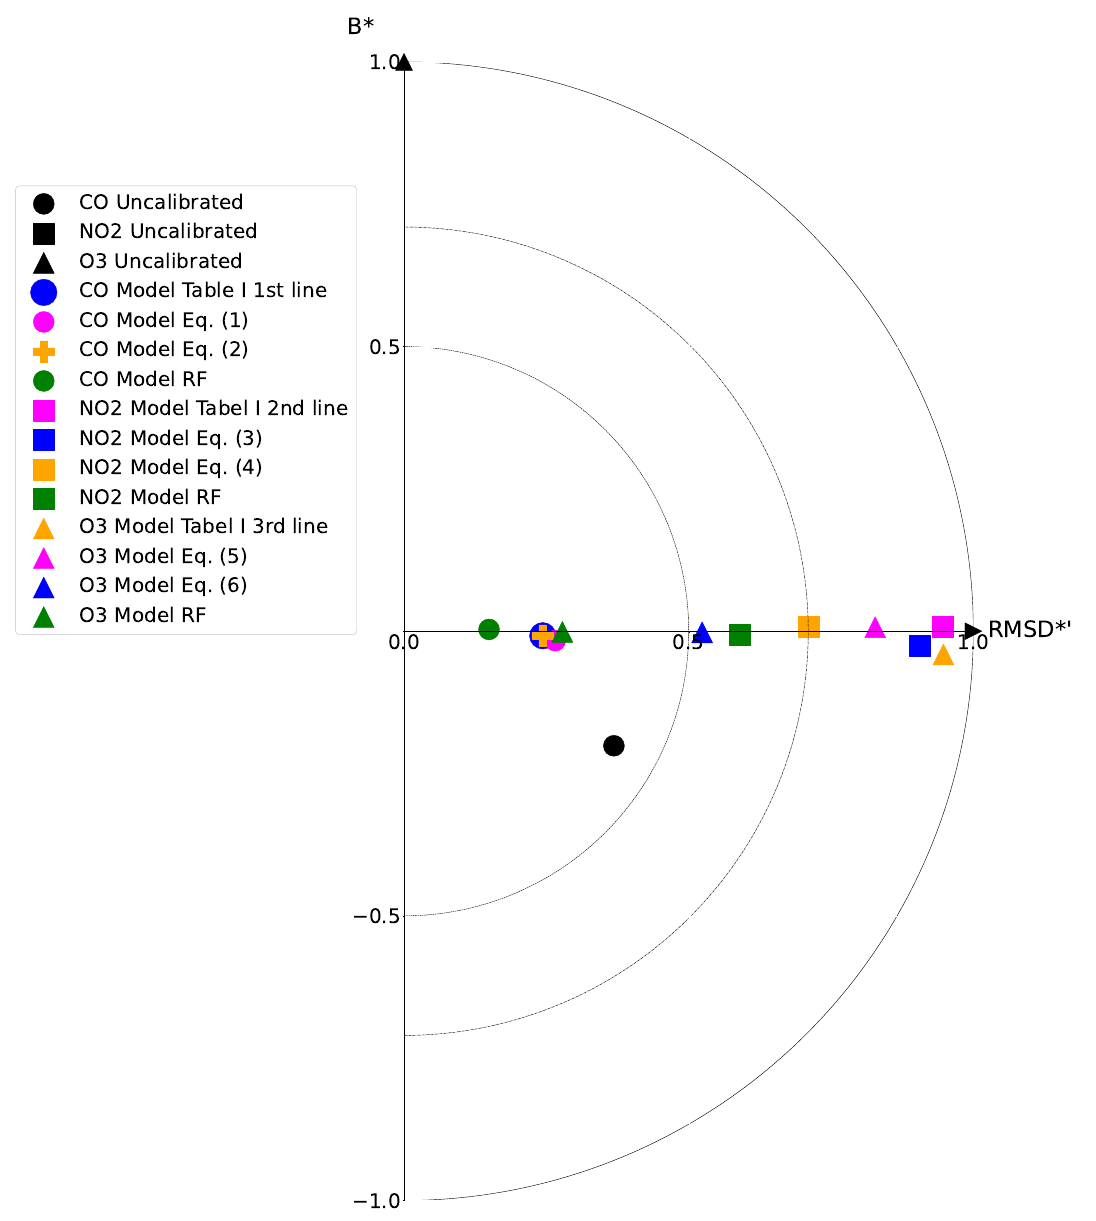
Figure 5. Target diagram for the proposed calibration models. For clarity, we present only the positive X of the target circle. The CO models except the RF one are overlapping around an RMDS*’ of 0.2 showing the good correlation between them. The uncalibrated NO 2 and the uncalibrated O 3 are outside the circle with radius 1 and are not present on the graph (nncalibrated NO 2 B* = 4.14, RMSD*’ = 1.11; uncalibrated O 3 B* = 14.32, RMSD*’ =